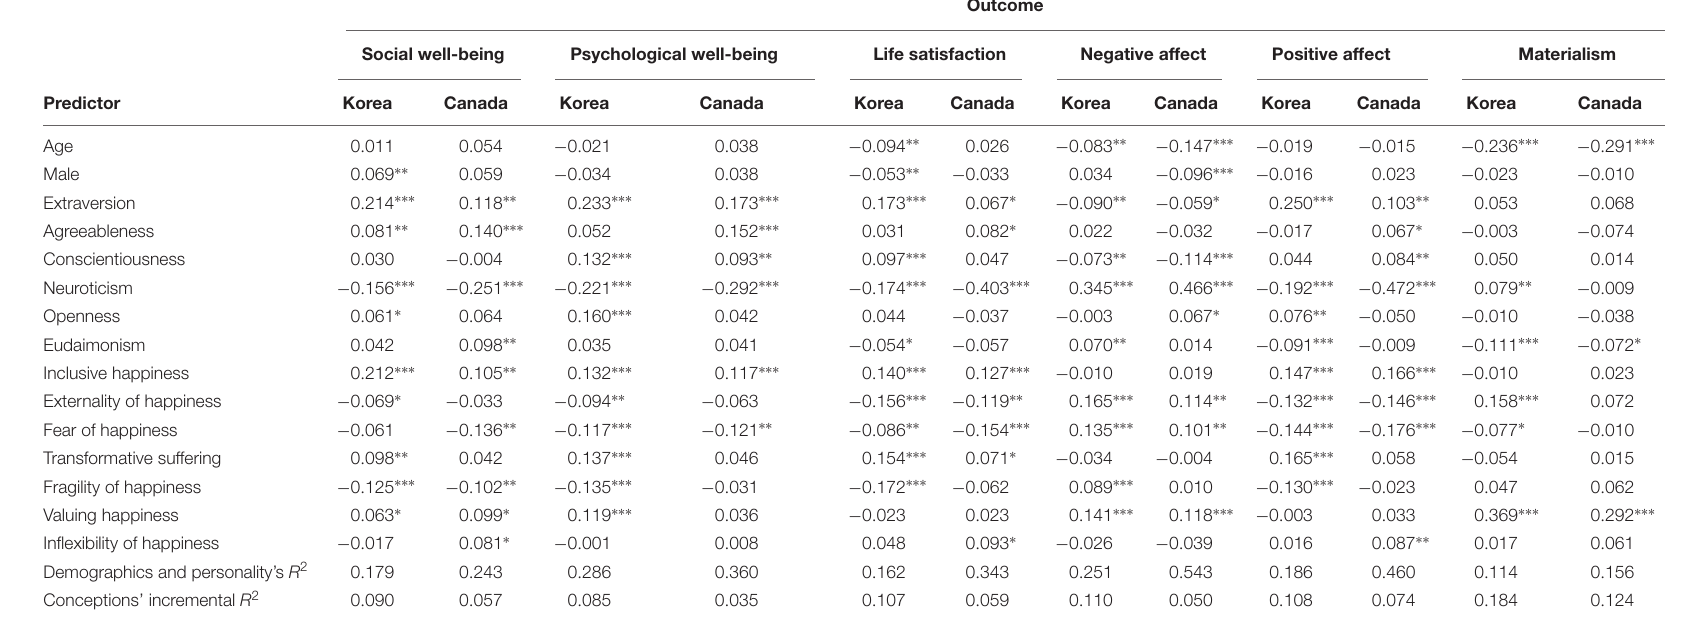
TABLE 5 | Conceptions of happiness predicting levels of well-being and materialism over and above age, gender, and the Big Five (standardized regression